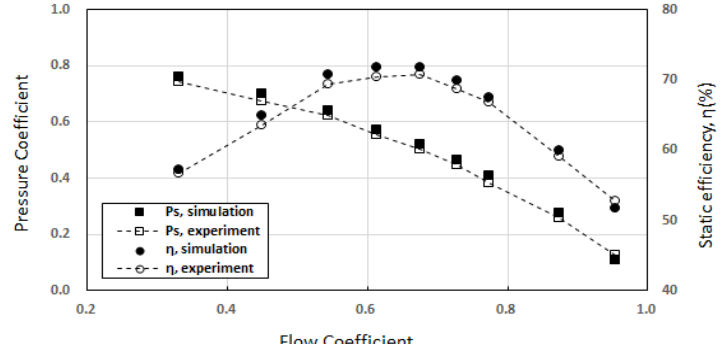
Figure 5. Comparison between the numerical and experimental results (at 1100 rpm).